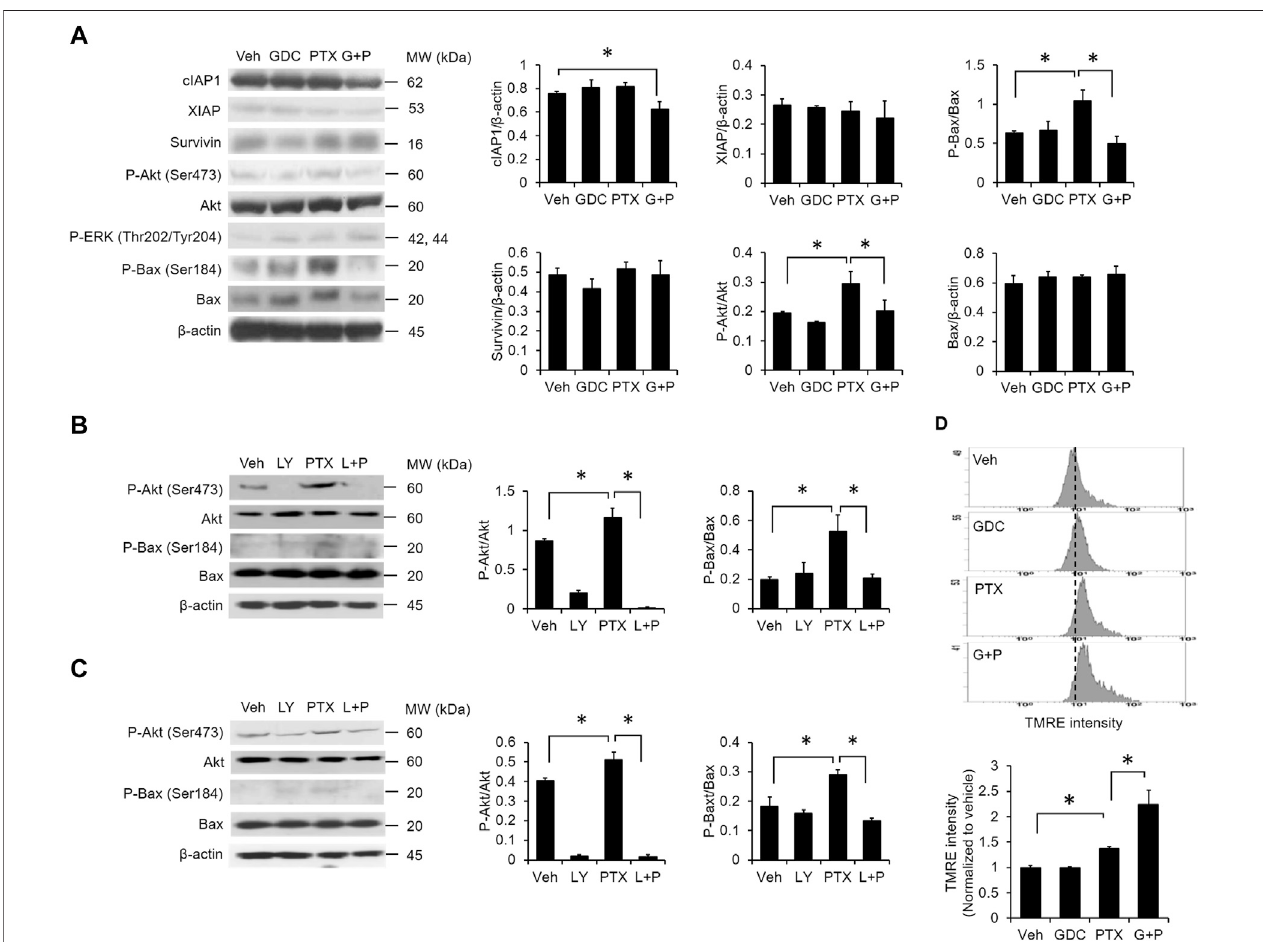
FIGURE 4 | Combination of PTX and GDC reduced Bax phosphorylation. (A) A549 cells were preincubated with GDC (20 μ M) for 1 h followed by PTX (20 nM) treatmentfor24 h.Totalcelllysateswereimmunoblottedusinganti-cIAP1,anti-XIAP,anti-survivin,anti-P-Akt,anti-Akt,anti-P-ERK, anti-ERK,anti-P-Bax,anti-Bax,and anti- β -actinantibodies.Proteinband intensitieswereanalyzed usingImageJ. *: p < .05;indicates astatistically signi fi cantdifference betweenindicatedgroups. A549 (B) andH1299 (C) cellswerepreincubatedwithLY294002(20 μ M)for1 hfollowedbyPTX(20 nM)treatmentfor24 h.Totalcelllysateswereimmunoblottedwithanti- P-Akt, anti-Akt, anti-P-Bax, anti-Bax, and anti- β -actin antibodies. Protein band intensities were analyzed using ImageJ. *: p < .05; indicates a statistically signi fi cant difference between indicated groups. (D) A549 cells were preincubated with GDC (20 μ M) for 1 h followed by PTX (20 nM) treatment for 24 h. Mitochondrial membrane potential was monitored by TMRE using fl ow cytometry. All experiments were performed at least three times. n = 3 for all groups.